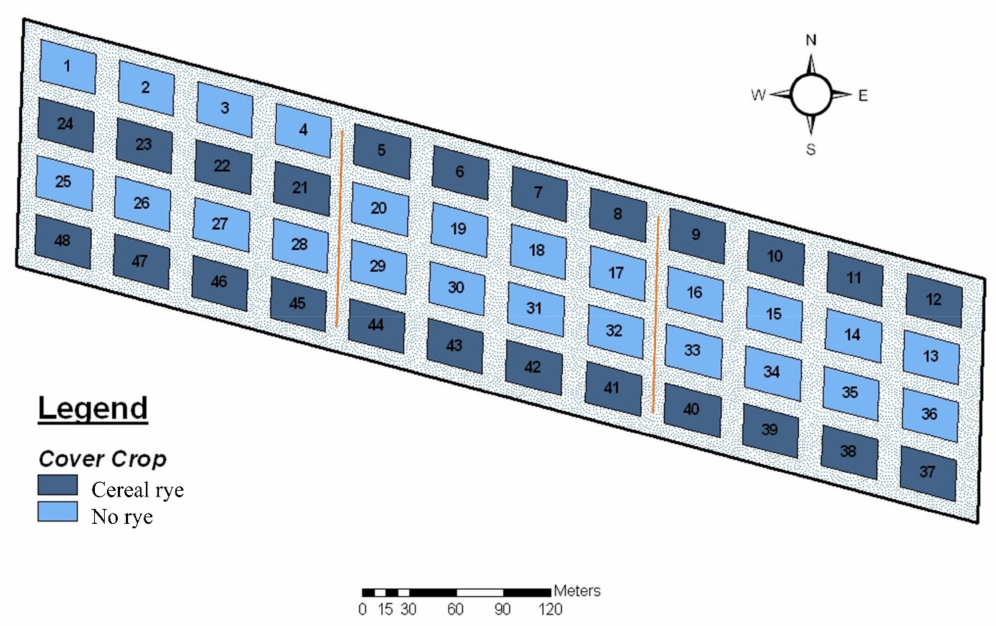
Figure 1. Experimental field at Freeman farm, Lincoln University of Missouri. Treatment-wise, there were three factors (tillage system, cover crop and crop rotation). However, the figure shows only cover crop at two